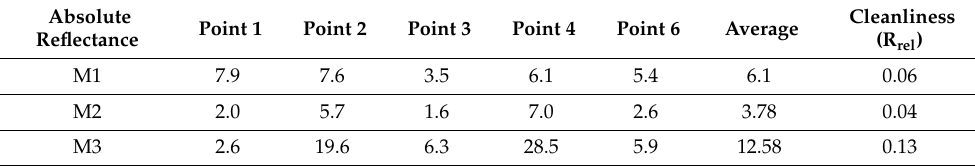
Table 3. Absolute reflectance (R abs ) [%] of intensively soiled mirror.